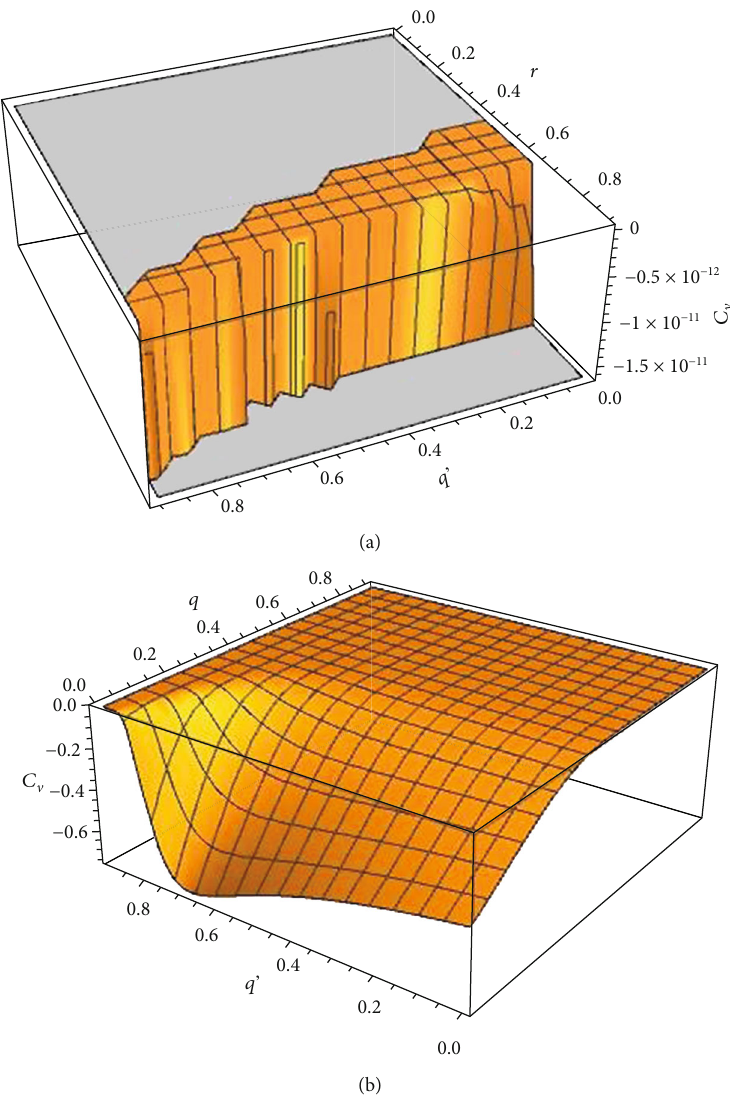
when q , q ′ vary and r = 0 : 8 , T = 3 , V ∗